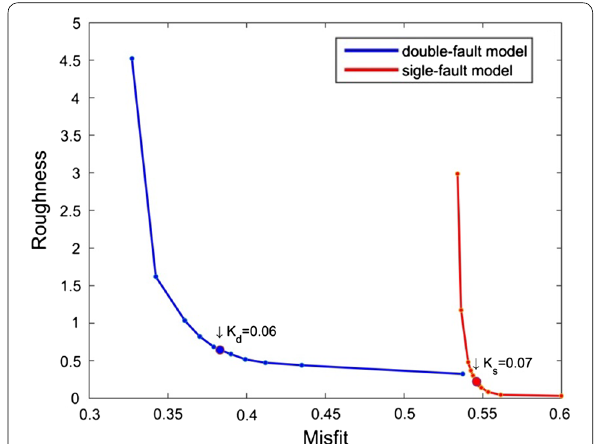
Fig. 4 Trade-off curve between relative fitting residuals and solution roughness for the double-fault model (blue line) and single-fault model (red